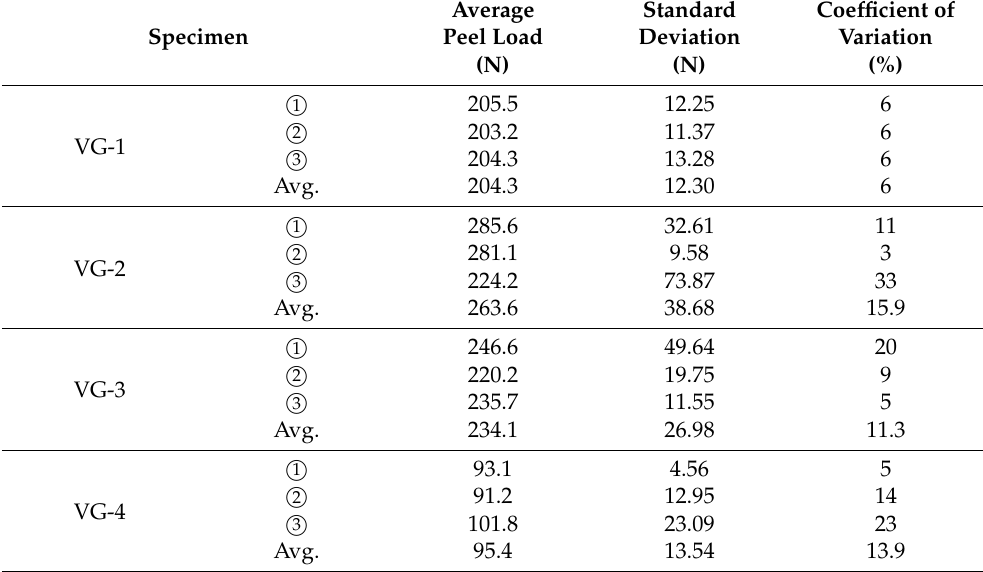
Table 9. The coefficient of variation of peel load